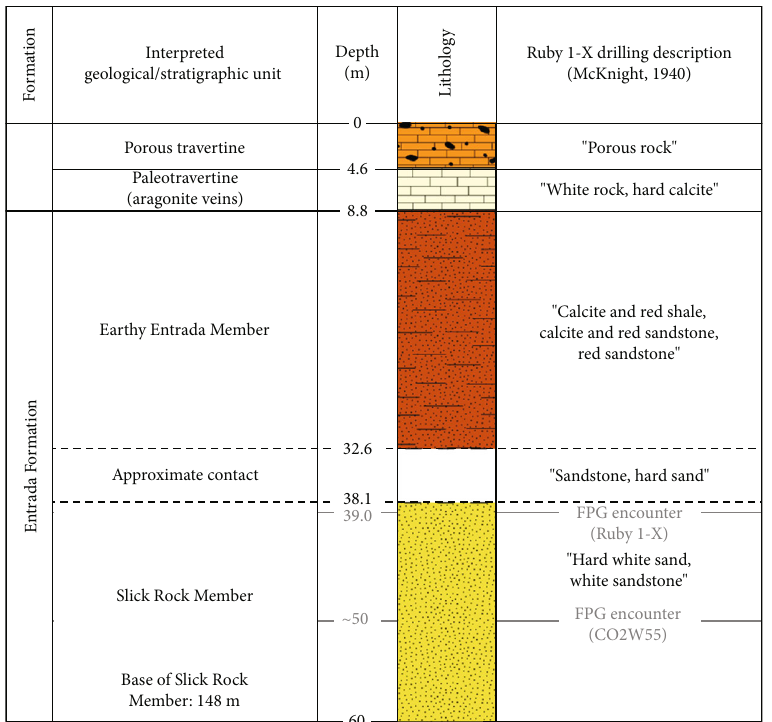
Figure 4: Crystal Geyser borehole log of interpreted geologic units to 60m depth. Crystal Geyser was drilled from 1935 to 1936 to a total depth of 801 m and was cased to at least 182 m [12, 22]. Lithology interpretations were based on descriptions from the Crystal Geyser (Ruby 1-X) driller ’ s log, corroborated with the CO2W55 log [12, 13]. The depths of drilling encounters with free-phase gas (FPG) are indicated for the Ruby 1-X and CO2W55 drilling